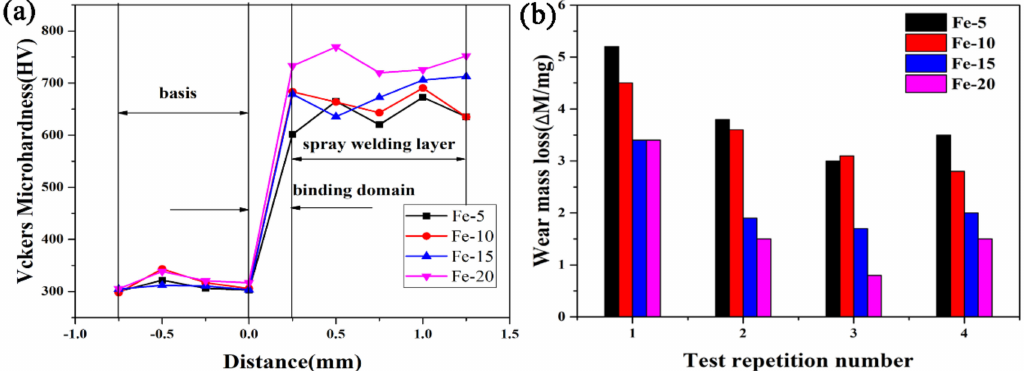
Figure 5. The influence of the Fe-based amorphous alloy content on the mechanical properties of the plasma spray welding layer: ( a ) microhardness and ( b ) wear mass